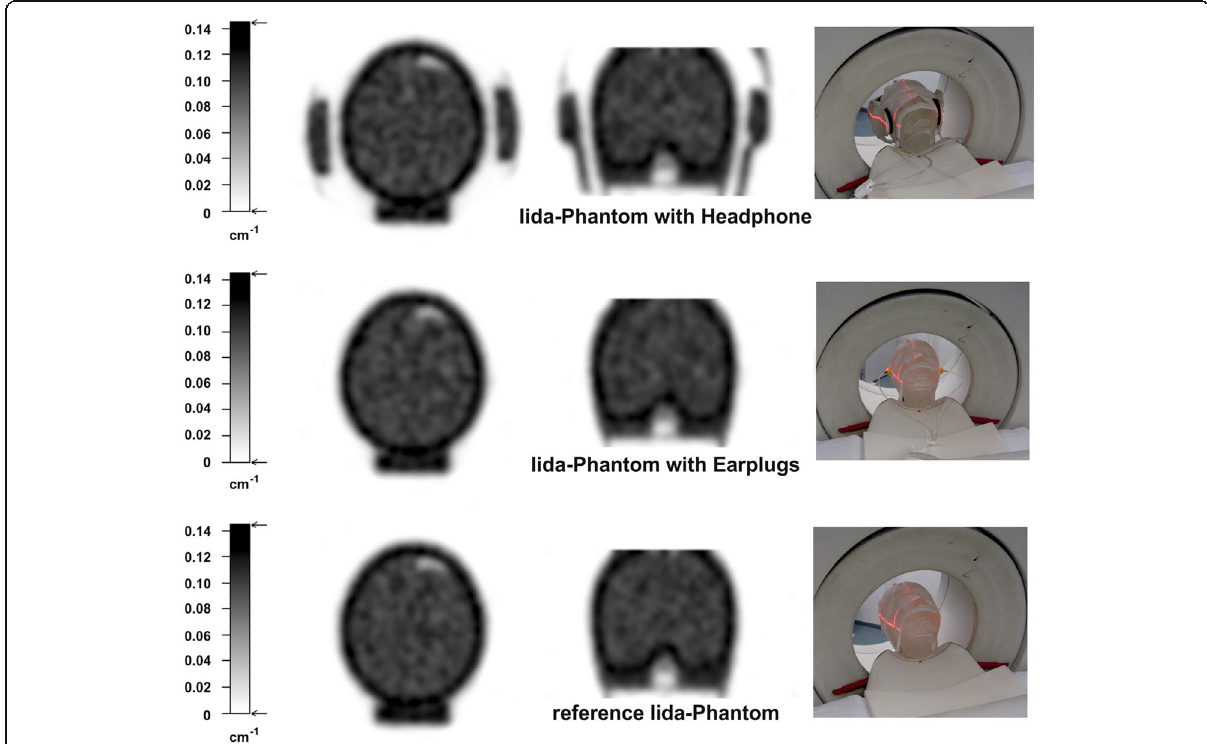
Fig. 2 Transmission images of the Iida phantom with headphones, earphones and without any phones (reference)